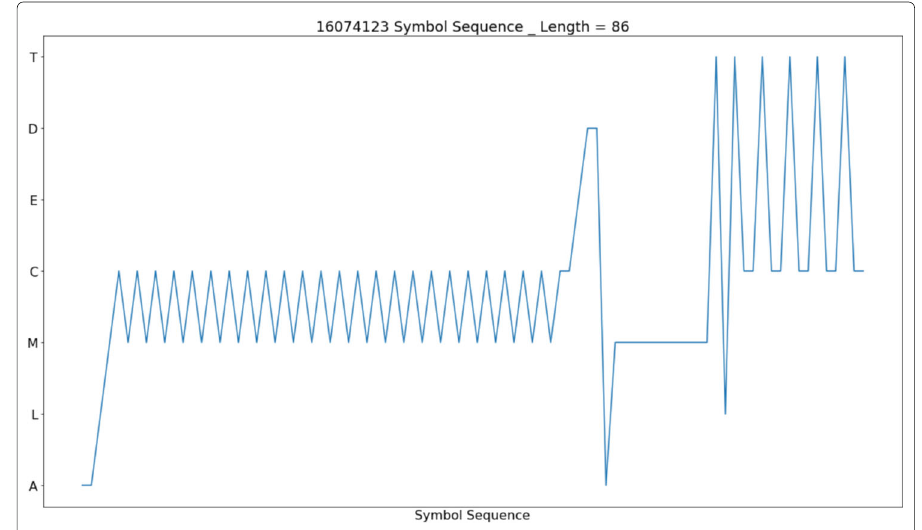
Fig. 6 Action Sequence of Student 16074123